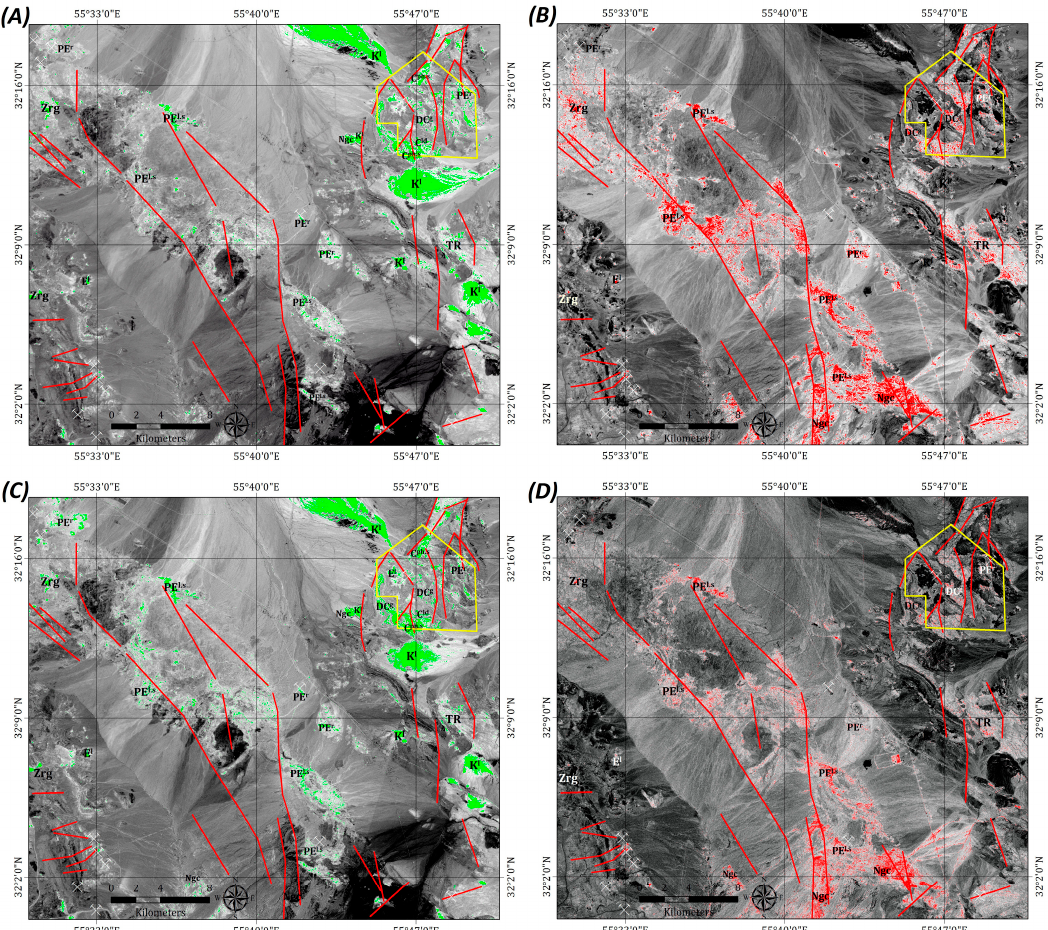
Figure 8. PC image-maps showing spatial distribution of iron oxide / hydroxides minerals and clay minerals and carbonates. ( A ) The PC4 image-map of Landsat-8 showing OH-bearing minerals and carbonates as green pixels; ( B ) the PC5 image-map of Landsat-8 showing iron oxide / hydroxides minerals as red pixels; ( C ) the PC4 image-map of Sentinel-2 showing OH-bearing minerals as green pixels; ( D ) the PC5 image-map of Sentinel-2 showing iron oxide / hydroxides minerals as red pixels. Yellow polygon demarcates WV-3